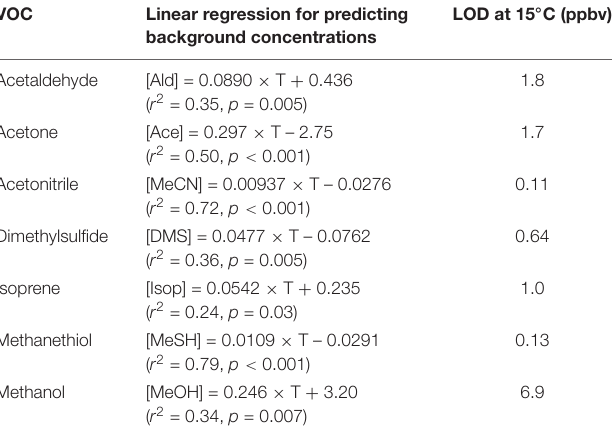
TABLE 1 | Linear temperature regressions used to derive background concentrations (ppbv) of target VOCs. VOC Linear regression for predicting LOD at 15 ◦ C background concentrations